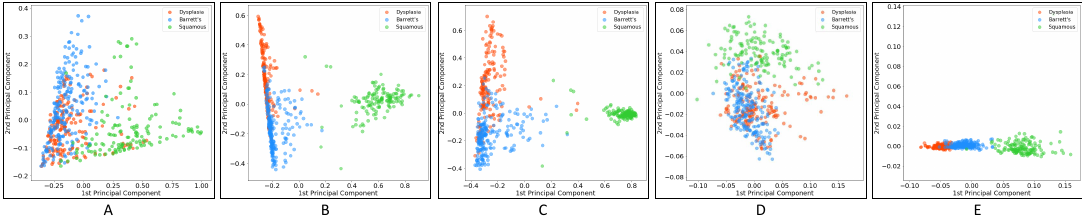
Figure 5. Principle component analysis (PCA) plot for WSIs encoded using ( A ) fully supervised, ( B ) multiple instance learning (MIL), ( C ) expectation-maximization (EM), ( D ) unsupervised (k-means), and ( E ) unsupervised (GMM) approaches.